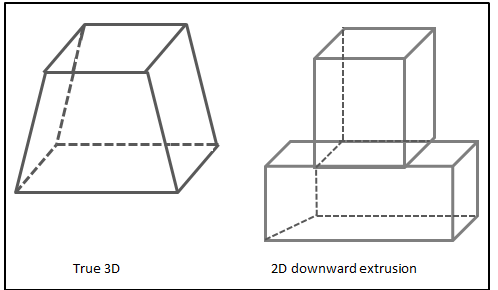
Figure 8: A strata plan on top of a surface model